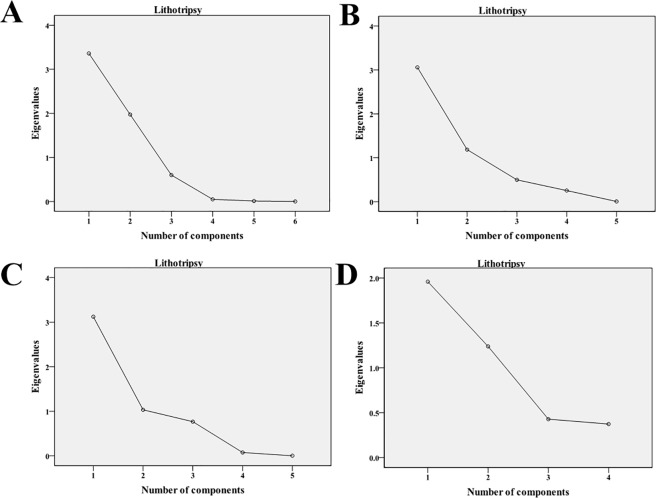
Main component gravel diagram of financial benefit evaluation index of investment project.(A is profitability; B is the debt risk; C is the operating capacity of assets; D is the ability to develop.).